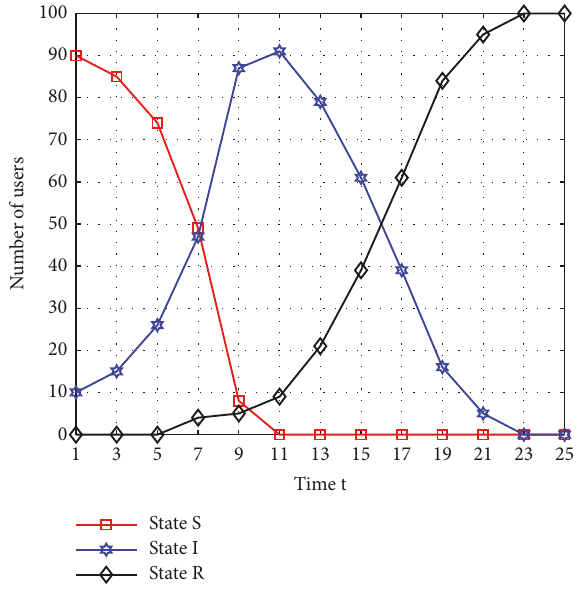
Figure 3: System convergence